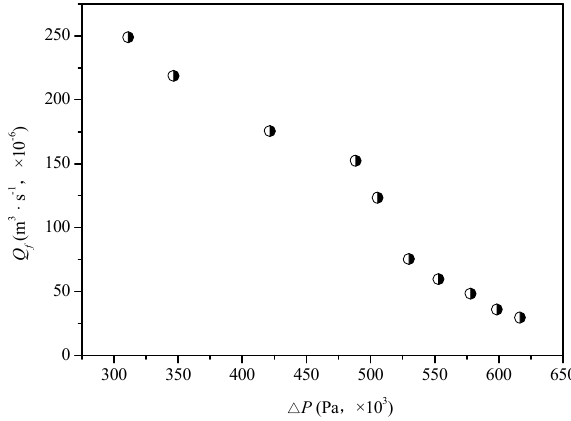
Figure 3. Relation between the feed solution flow and the transmembrane pressure.